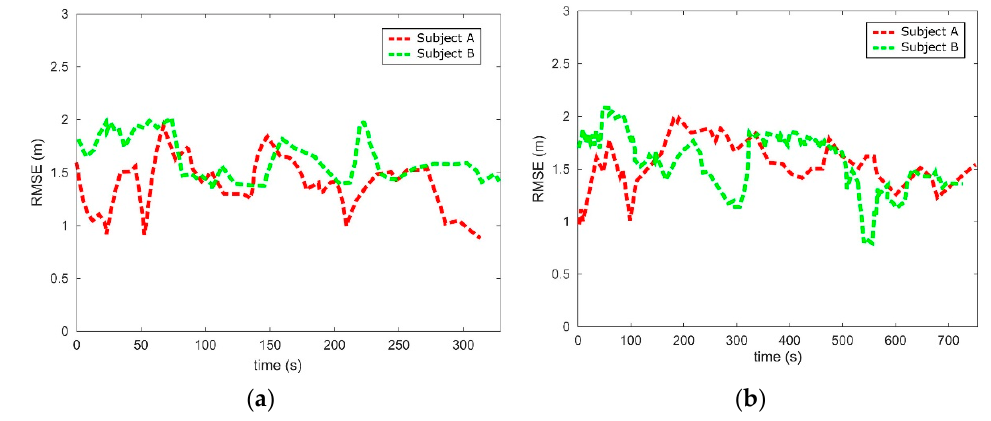
Figure 13. The A-GPS accuracy observed during the urban mobility task: ( a ) E-1 and ( b ) E-2.